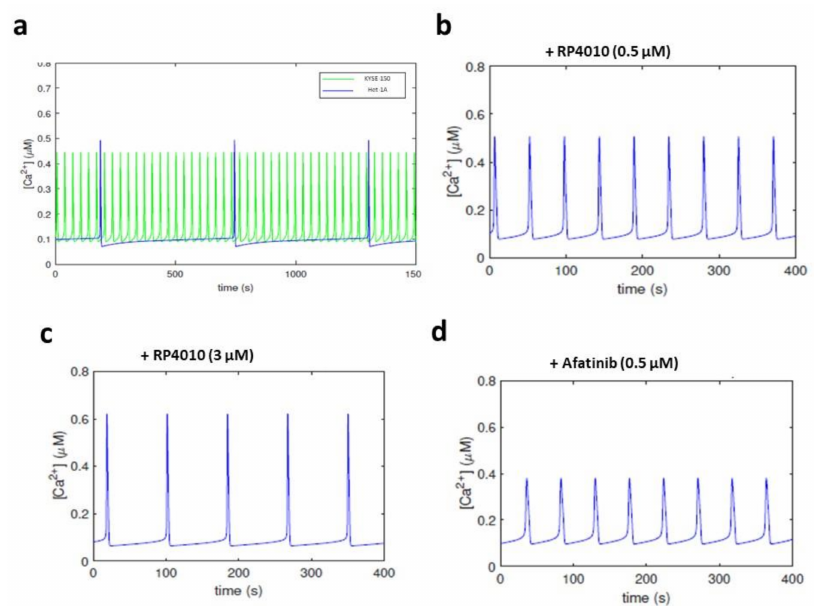
Figure 3. Ca 2+ oscillations simulated by mathematical modeling. ( a ) Simulated Ca 2+ oscillations in KYSE-150 (green line) and Het-1A cells (blue line). ( b , c ) Simulated Ca2+ oscillations in KYSE-150 cells treated with RP4010 at the concentration of 0.5 µ M ( b ) or 3.0 µ M ( c ). ( d ) Simulated Ca 2+ dynamics in KYSE-150 cells treated with afatinib at the concentration of 0.5 µ M.